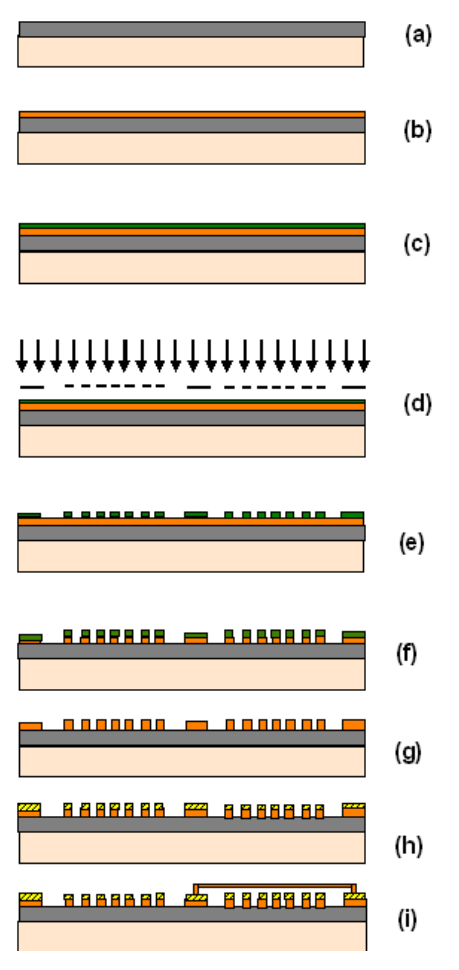
Figure 4: Manufacturing steps of the spiral inductor